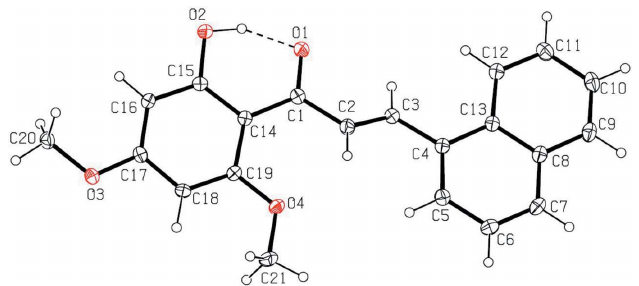
Figure 1 The molecular structure of the title compound, showing the atom-labeling scheme and displacement ellipsoids drawn at the 50% probability level. The dashed bond represents the intramolecular O—H (cid:3)(cid:3)(cid:3) O hydrogen